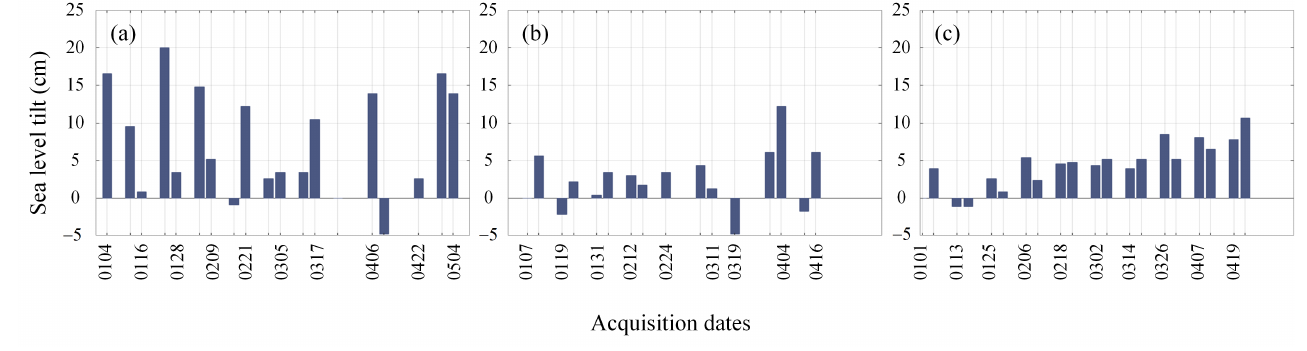
Figure 13. Sea-level tilt between Cambridge Bay and Austin Bay: ( a ) 2019, ( b ) 2020, and ( c )